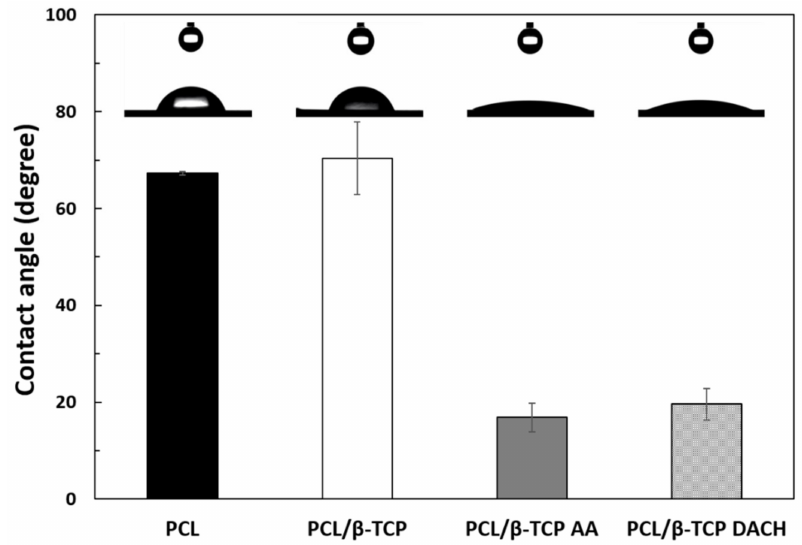
Figure 6. Water contact angles of PCL, PCL/ β -TCP, PCL/ β -TCP AA and PCL/ β -TCP DACH